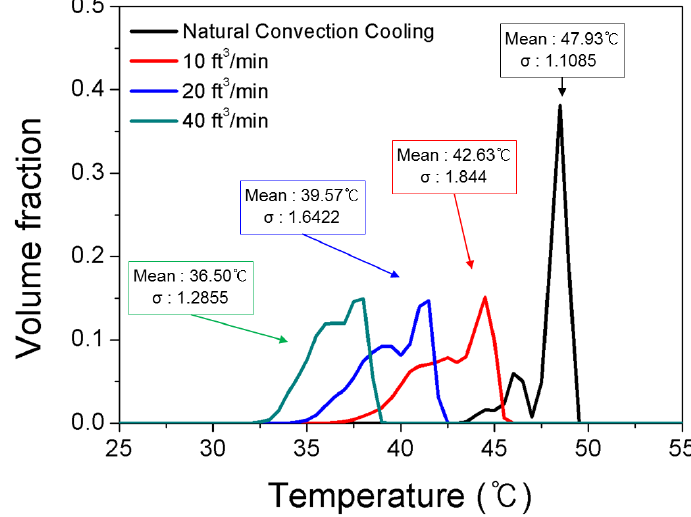
Figure 12. Distributions of the volume fraction of the LIB cells within the module as a function of temperature at the discharge time of 1680 s with the discharge rate of 2 C for various cooling